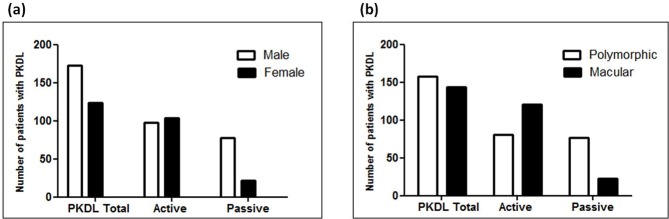
Impact of surveillance upon gender and lesional distribution in PKDL.(a) Bar diagram showing the overall distribution of males and females in the PKDL population, as also following passive or active surveillance (b) Bar diagram showing the overall distribution of polymorphic and macular lesions in the PKDL population, following detection by passive or active surveillance.